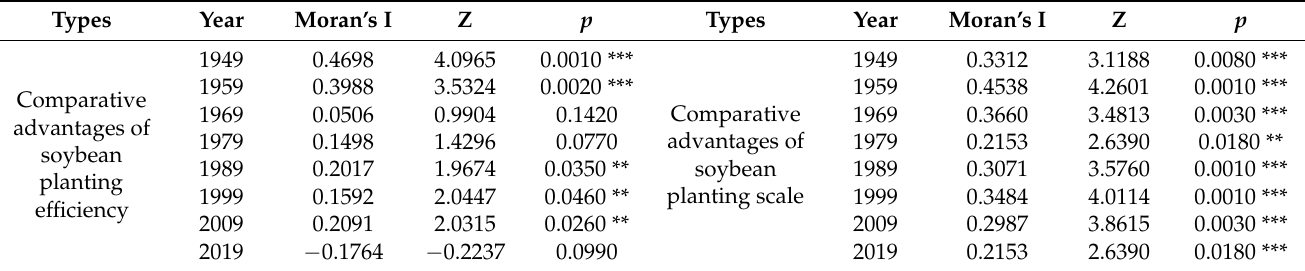
Table 2. Change in the Global Moran’s I index of comparative advantages in soybean planting efficiency and scale in China from 1949 to